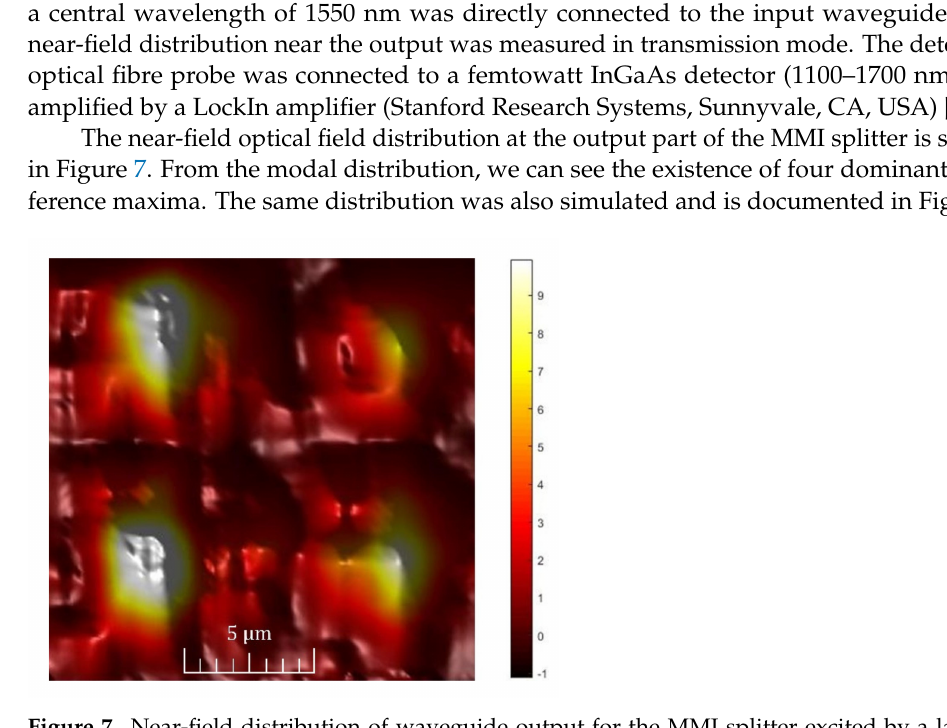
Figure 7. Near-field distribution of waveguide output for the MMI splitter excited by a laser at 1550